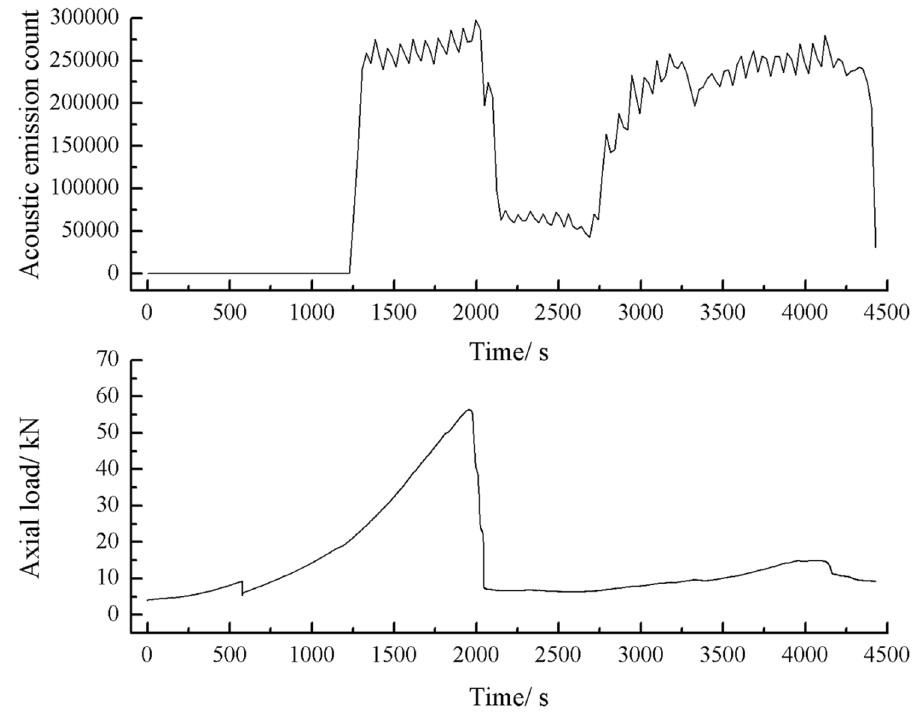
Figure 45. Acoustic emission count-Axial load of the specimen with 2 cm crack.